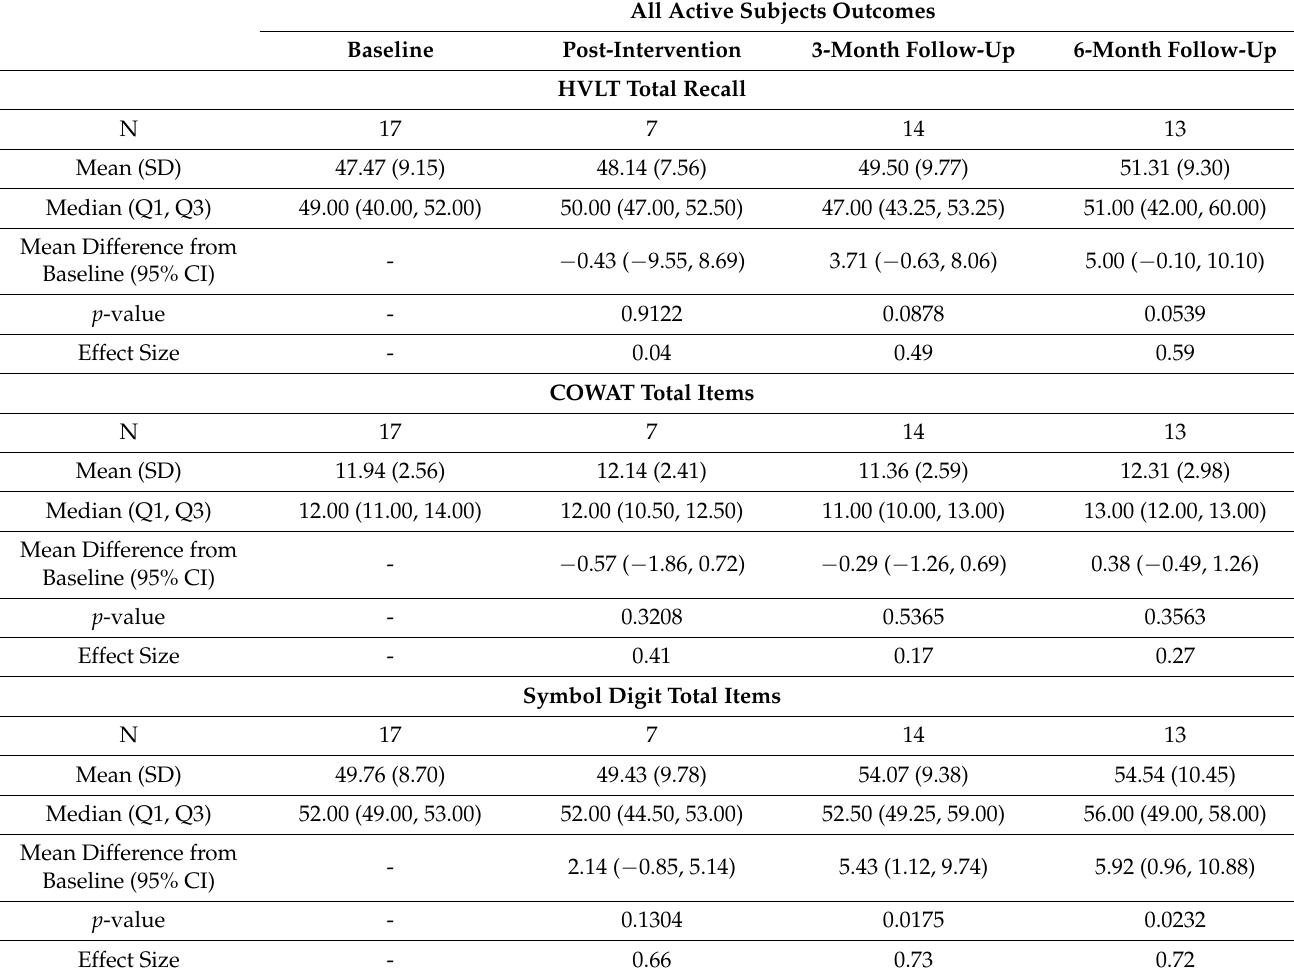
Table 4. Cognitive outcomes at all timepoints. All active participants